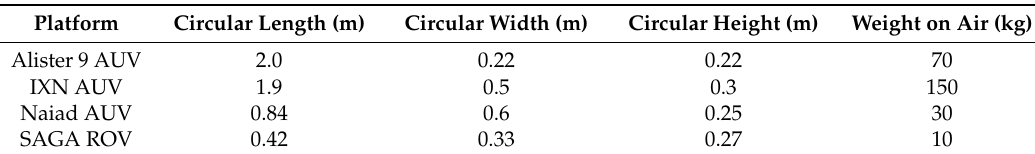
Table 6. The parameters of the underwater vehicles (AUVs and ROVs) employed in the SWARMs environmental sensing mission.